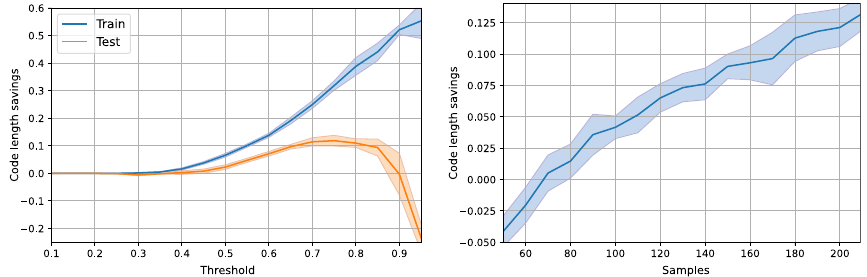
Fig. 6 Gene co-expression data. Applying the proposed method to gene co-expression data from the plant Arabidopsis thaliana shows that the code length savings in the test network has a maximum at threshold τ ∗ ≈ 0.75 (left). This is the threshold value giving the most parsimonious model of the data. The right figure shows that the code length savings at the optimal threshold do not increase linearly with the number of samples, indicating in accordance with the results based on synthetic data that the reward for sampling effort decreases as the number of samples